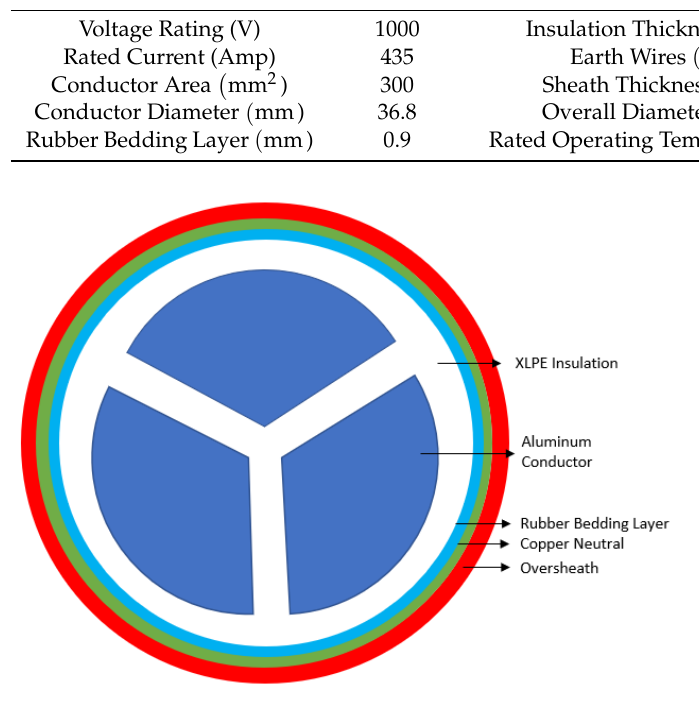
Figure 4. Layout of the 300 mm 2 waveform cable.